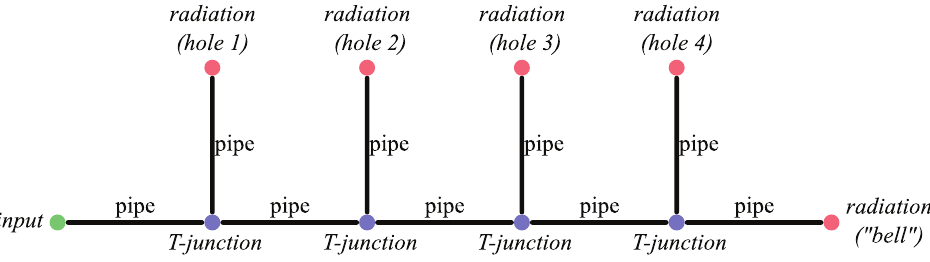
Figure 2. The network representation of the studied resonator is composed of 9 pipes and 10 connection conditions.